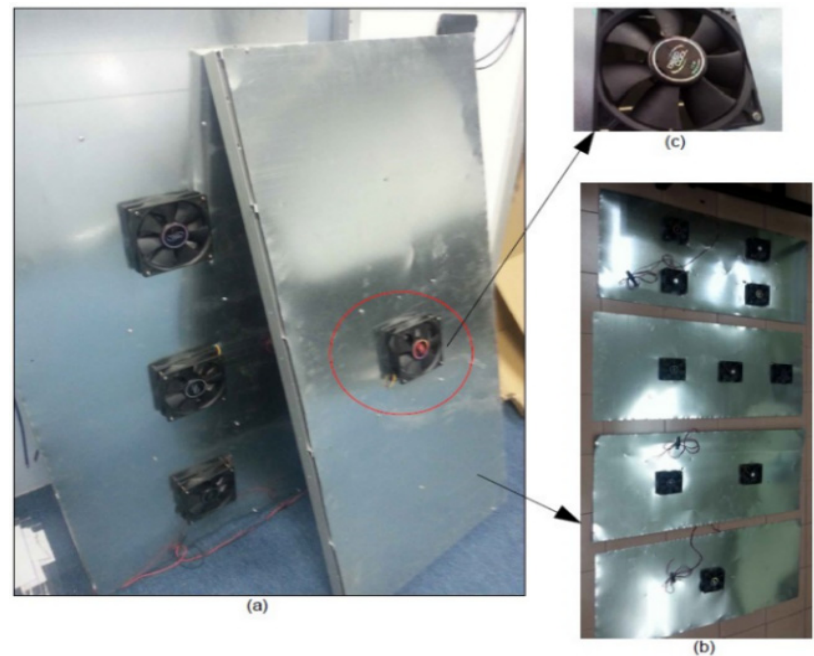
Figure 10. ( a ) Development of DC fan cooling mechanism and temperature distribution through the front surface PV panels for different mode operation PV panel temperature, ( b ) rear side of the panel having a ( c ) DC fan